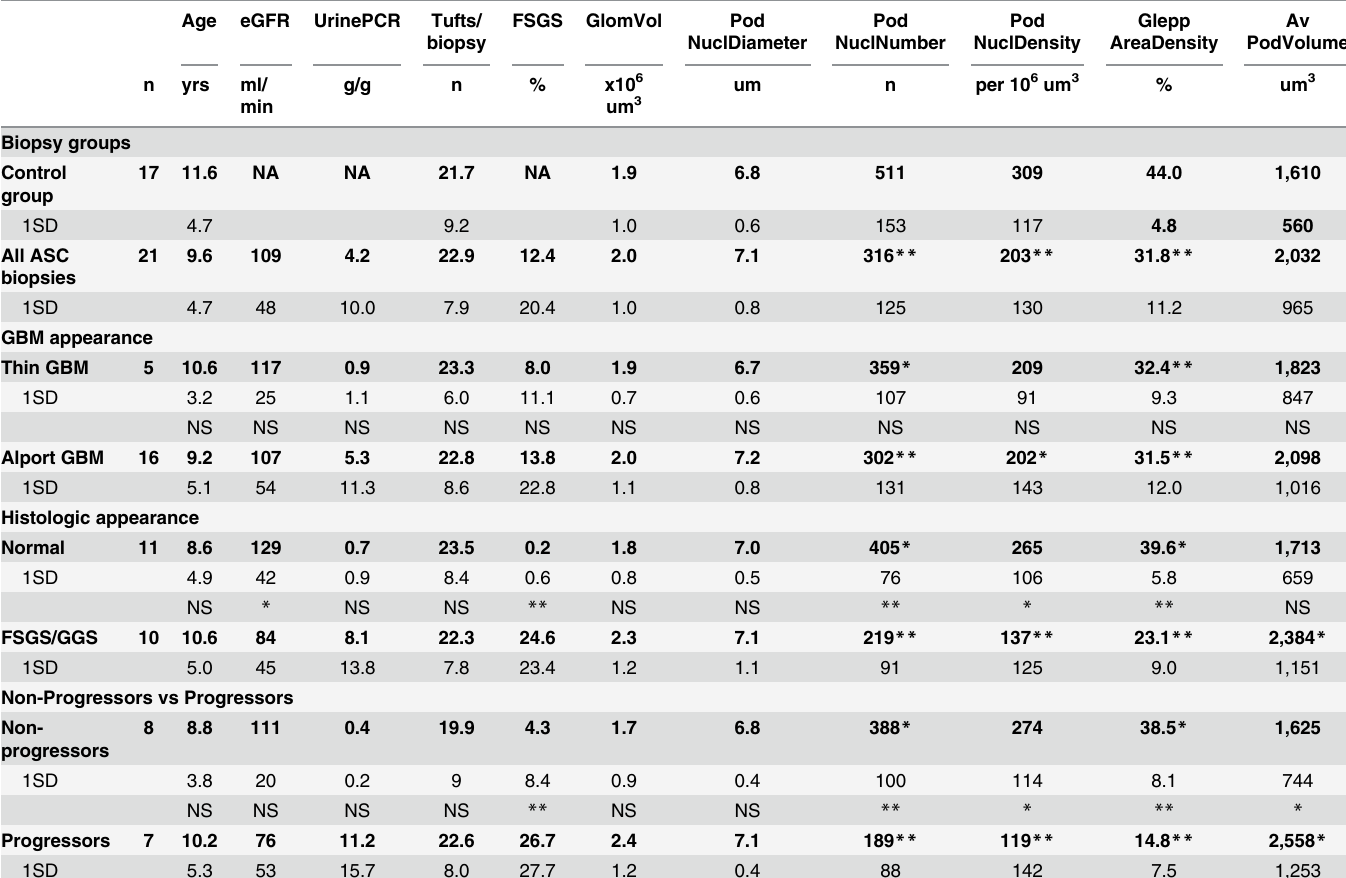
Table 2. Clinical groupings showing podocyte depletion in ASC. Clinical parameters are shown to the left side and podometric parameters to the right side of the Table. Since age impacts podometric parameters the control group (n = 17 biopsies from deceased kidney donors aged 4 – 17 years) is appropriate for the ASC group (n = 26 biopsies from 21 patients aged 2 – 17 years). For cross-sectional analysis where more than one biopsy data set is available from one patient a single averaged value is used. Clinical parameters shown are from the time point at which the biopsy was performed. eGFR and urine protein: creatinine ratio (Urine PCR) data are not available (NA) for the control group. For each data set the mean (above in bold) and 1SD (below) are shown. Statisti- cal comparisons of each data set compared to control using t-tests are shown by superscripted asterisks, while comparisons between sub-groups using anal- ysis of variance are shown by asterisks in the area between the two sub-groups being compared. ( * = P < 0.05, ** = P < 0.01). Group Comparison: All ASC subjects (n = 21) compared with control (n = 17) shows that glomerular volume was not different. However, podocyte number per glomerular tuft, podocyte nuclear density and podocyte cell (Glepp1 area density) were all decreased in ASC biopsies compared to control. Mean podocyte cell volume and mean podocyte nuclear diameter were not statistically significantly increased in ASC glomeruli. GBM appearance: Alport GBM is defined as typical alternating thin and thick GBM with lamellated lamina densa. Both the Thin GBM group (n = 5) and the Alport GBM group (n = 16) had significantly reduced podocyte number per tuft and Glepp1 area density compared to controls. The Thin GBM and Alport GBM groups were not significantly different from each other by any parame- ter (probably because one patient in the Thin GBM group progressed to ESKD in association with podocyte depletion). Histologic appearance: Biopsies containing only normal-appearing glomeruli without FSGS contained fewer podocytes and lower podocyte cell (Glepp1) area density than control. Biopsies with FSGS and/or global glomerulosclerosis (GGS) had significantly fewer podocytes (podocyte number per glomerulus, density or podocyte area density) than both control and ASC biopsies with normal appearing glomeruli. “ Non-progressors ” vs Progressors : Biopsies from people who did not progress ( “ Non-progressors ” ) as judged by retaining eGFR within the normal range by follow-up of 3 or more years (mean follow-up 7.4 ± 3.9 years, n = 8) had significant podocyte depletion (reduced number of podocyte per glomerulus and reduced podocyte area [Glepp1 area density] compared to control. Biopsies from